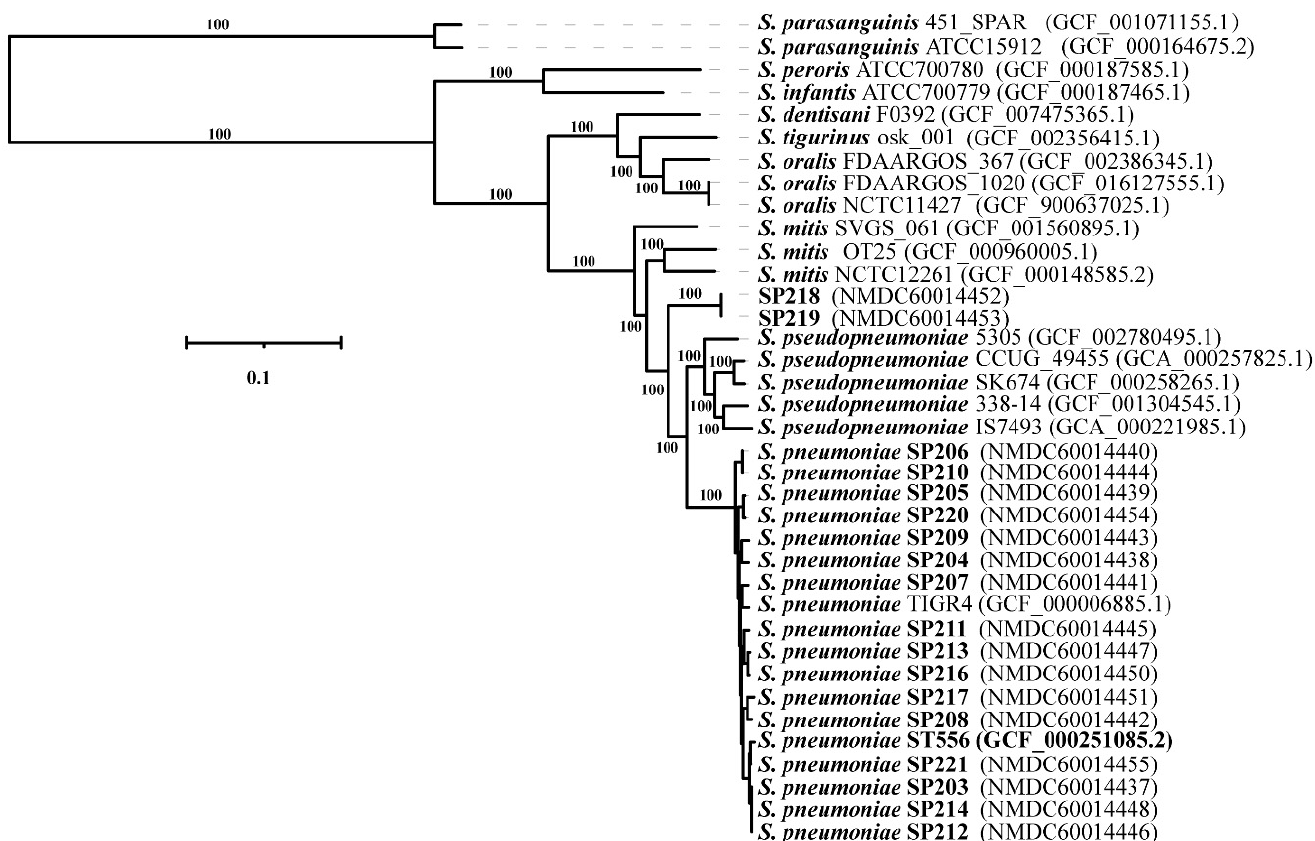
Figure 1. Whole-genome maximum-likelihood phylogenetic tree constructed using 687 core genome sequences from 18 clinical isolates and 19 genomes obtained from Refseq belonging to MGS. The sequences of S . parasanguinis ISU2812 and S . parasanguinis NCTC10234 were used as the root. Numbers at major branches represent bootstrap values based on 100 replications. The bar indicates changes per nucleotide position.